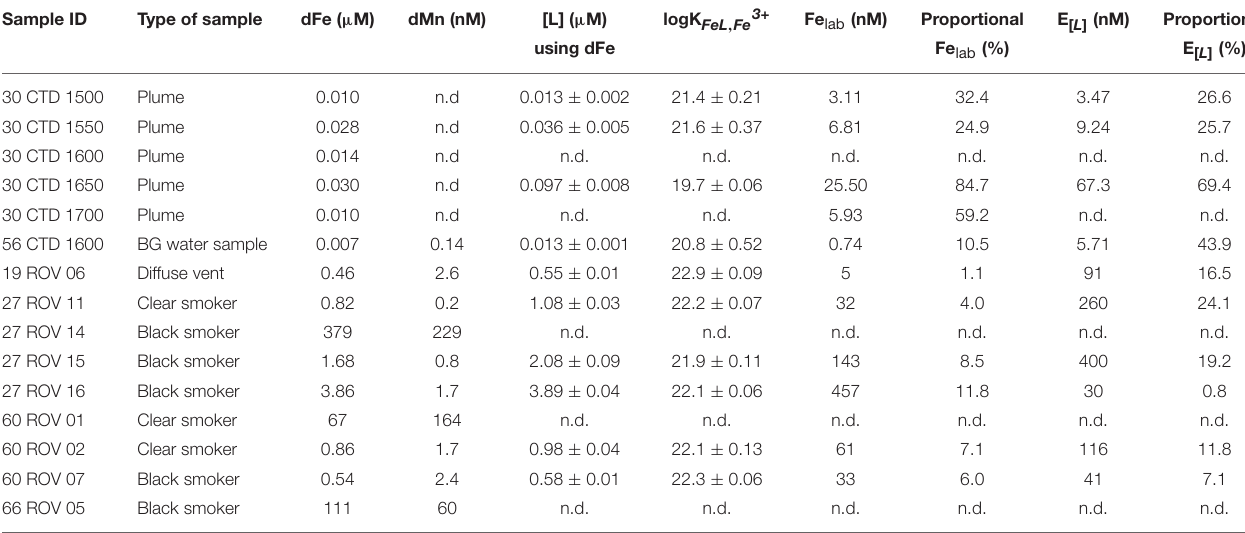
TABLE 3 | Iron speciation data for hydrothermal plume and fluid samples taken on SO 229. Sample